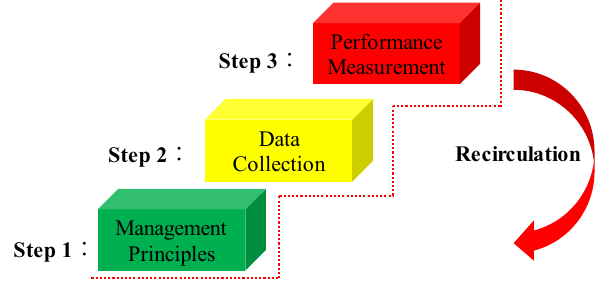
Fig. 6 Execution of LSCM for